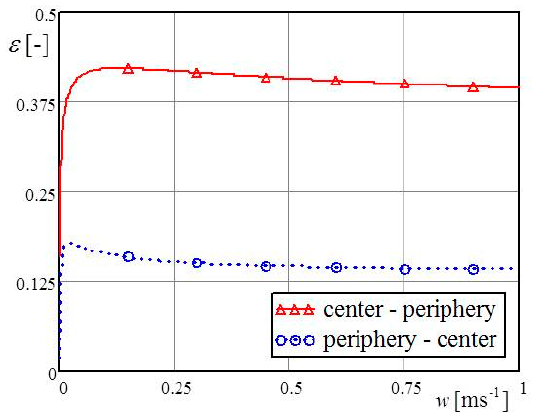
Figure 16. The effectiveness of direct and counter impinging liquid jet.